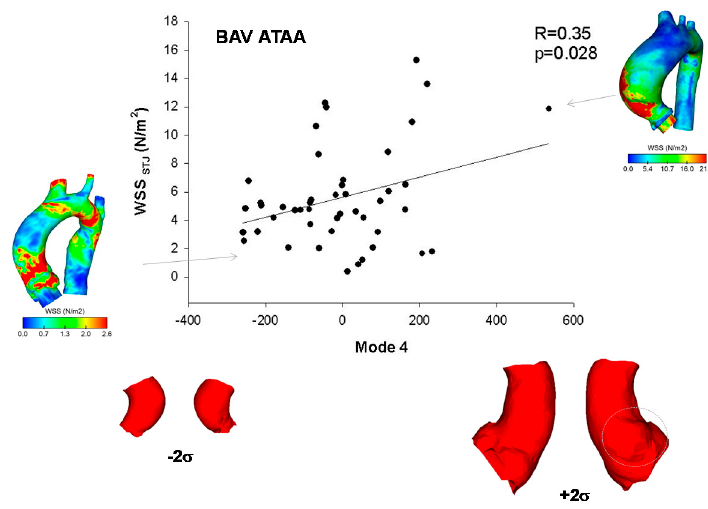
Figure 5. Correlation of wall shear stress (WSS) computed at STJ of BAV ATAA with Mode 4, as associated to a bulged dilatation of the anterolateral side of ATAA wall; map of WSS of patients being at extremity are also shown.